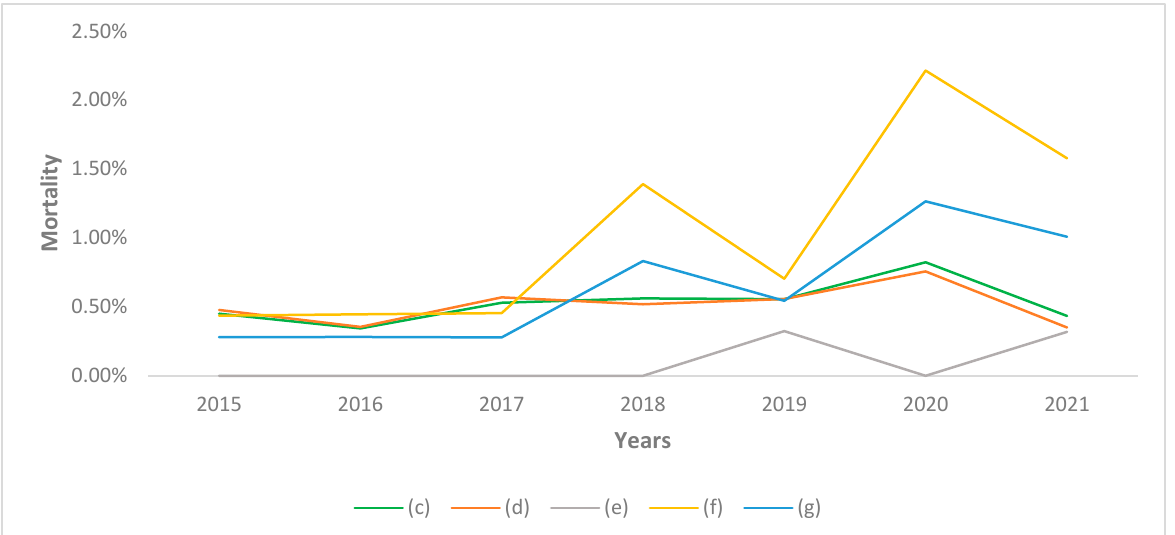
Figure 5. Mortality rate among physicians and dentists in the province of Pavia. (c): All Doctors, (d): Physicians, (e): Dentists, (f): Physicians-Dentists, (g): All Dentists.